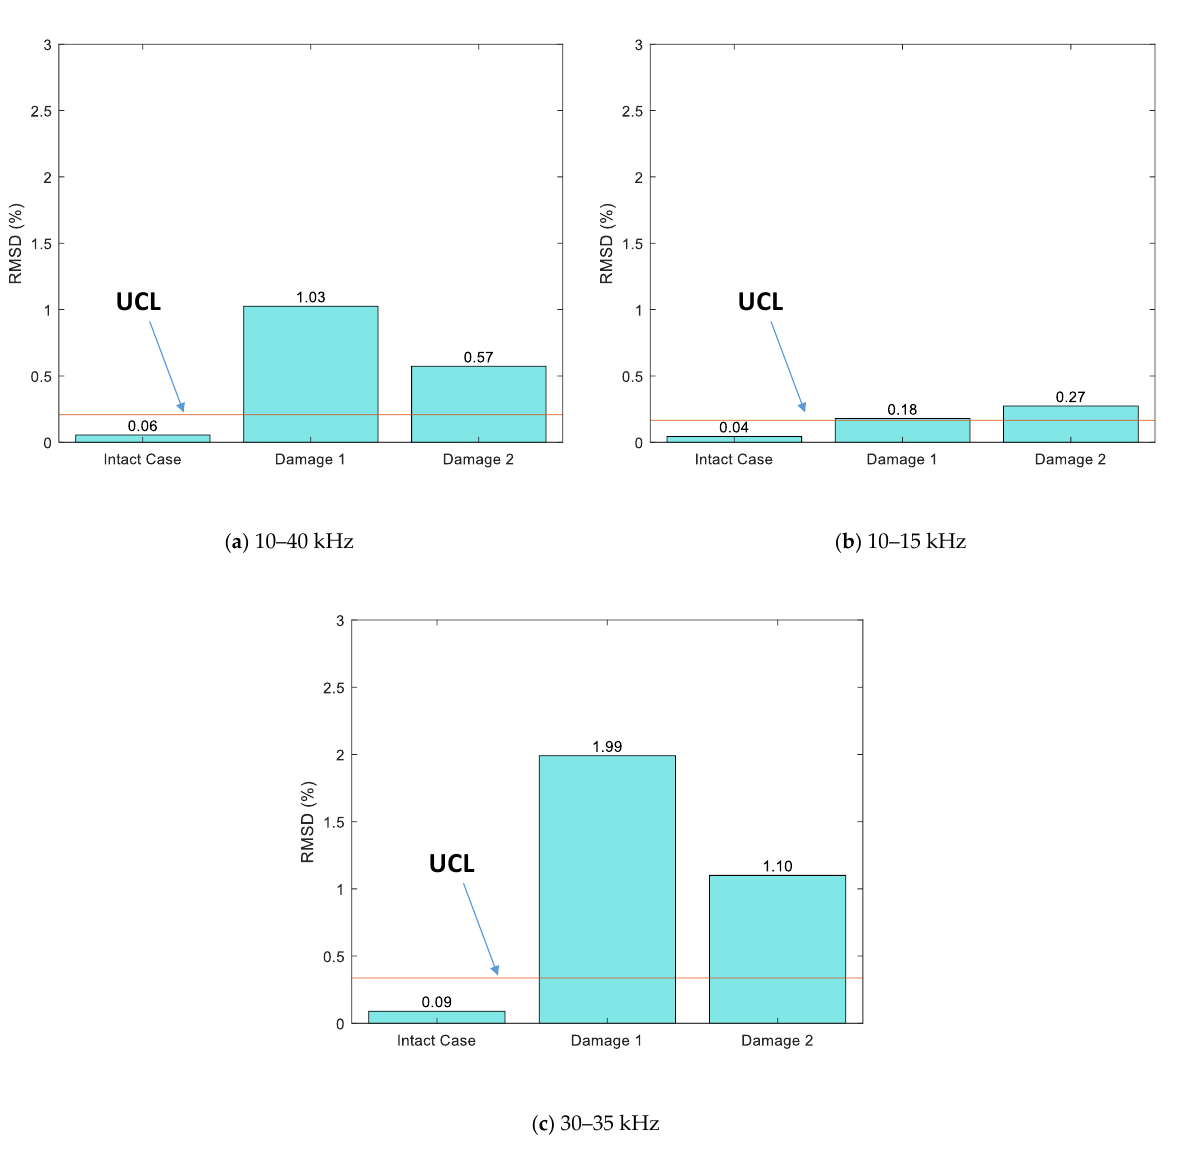
Figure 11. RMSD metric of measured admittance response under damage cases: damage distant from the transducer (the first test scenario).